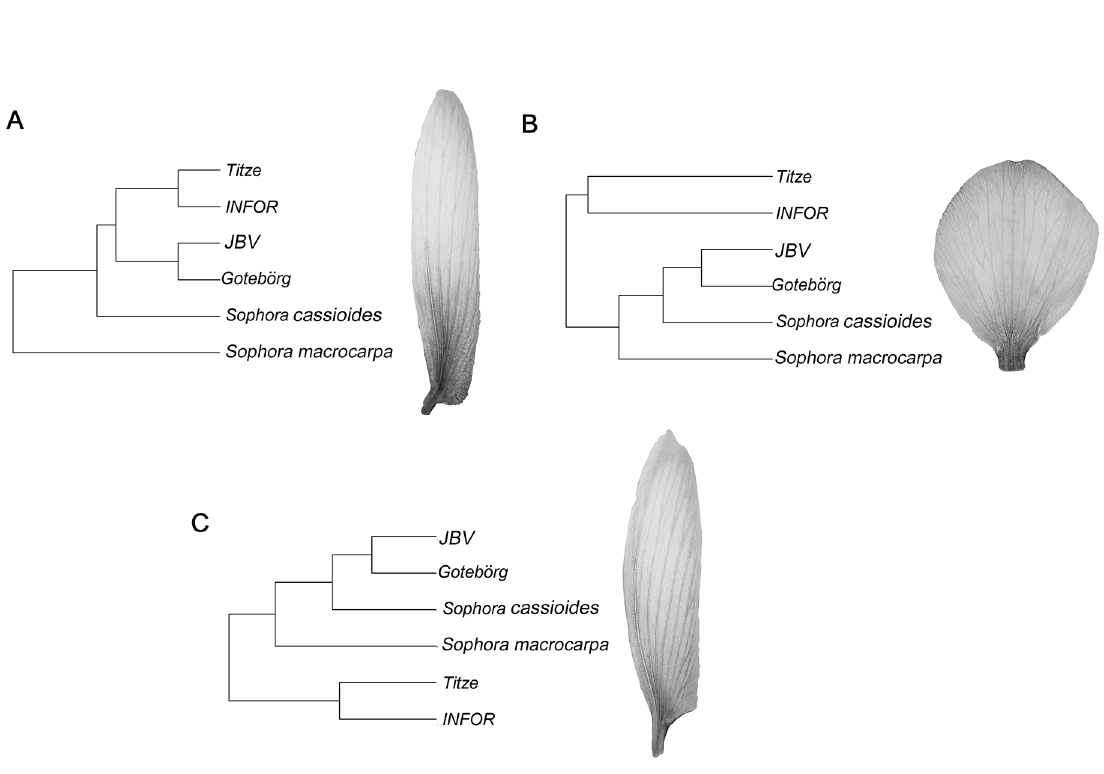
Sums of squares (SS) and mean squares (MS) are in units of Procrustes distances (dimensionless).